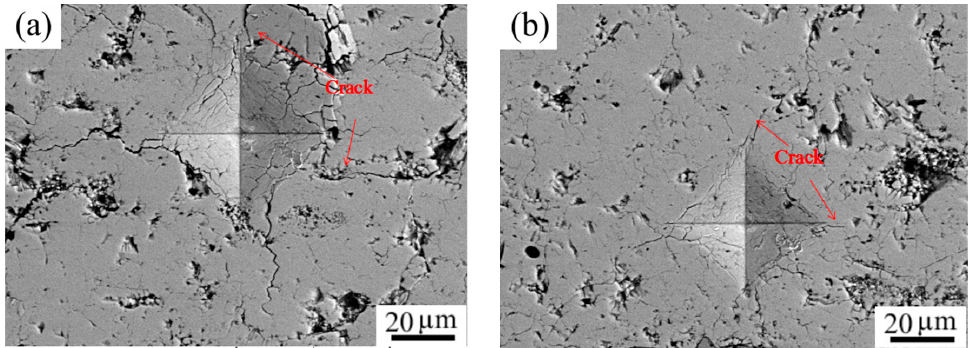
Figure 7. The morphology of the Vickers indentation and cracks on the polished cross-section of as- sprayed coatings: ( a ) C3 and ( b ) C11.